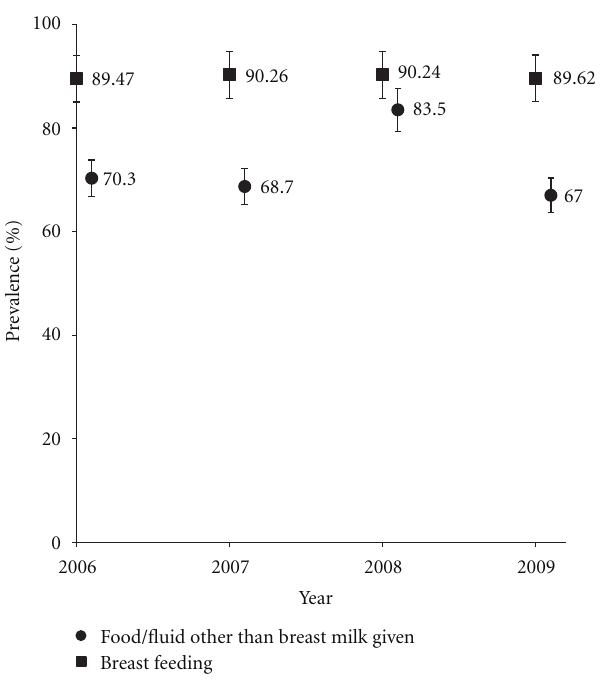
Figure 1: Infant feeding practices between 2006 and 2009.